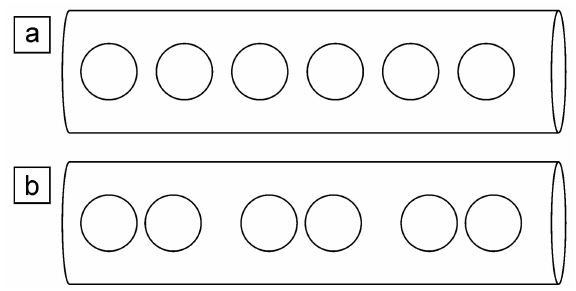
Figure 1. Scheme of the simplest possible vortex configurations In nanowire according to the simulation [24]: 1D lattice of single-quantum vortices ( a ) and a row of single-quantum vortices divided into pairs ( b ). Circles are superconducting